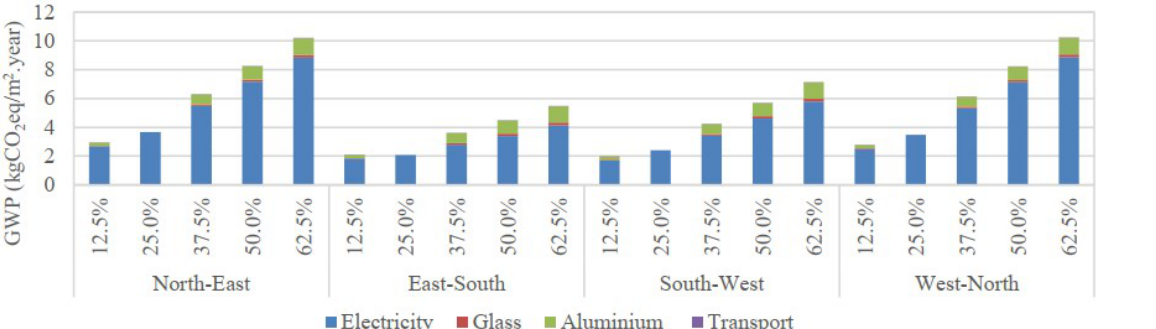
Figure 5. Global Warming Potential impact per m 2 · year – WWR scenarios.